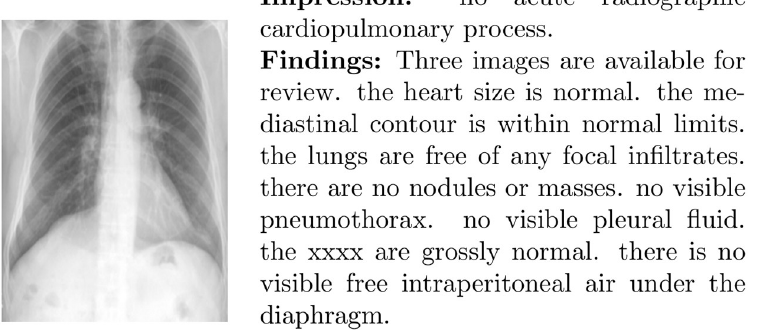
Fig 1. Example of impression and findings sections of a radiology report (Indiana U. Chest X-ray dataset). xxxx’s indicate removed keywords due to